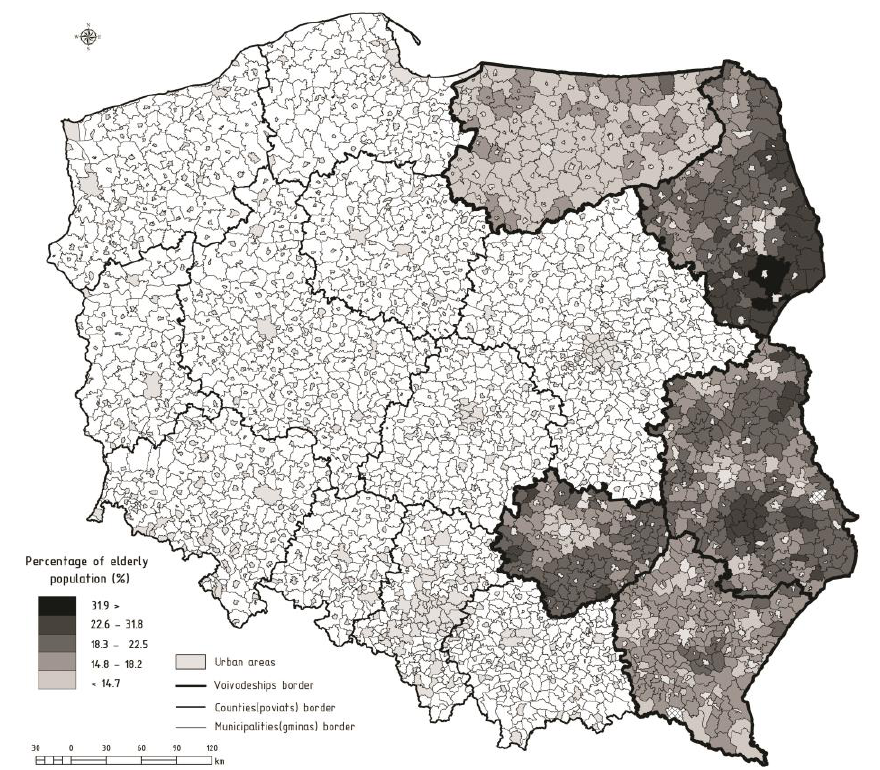
Fig. 4. The percentage of the post-working age population in rural areas of Eastern Poland in 2008 (Source: calculations of the